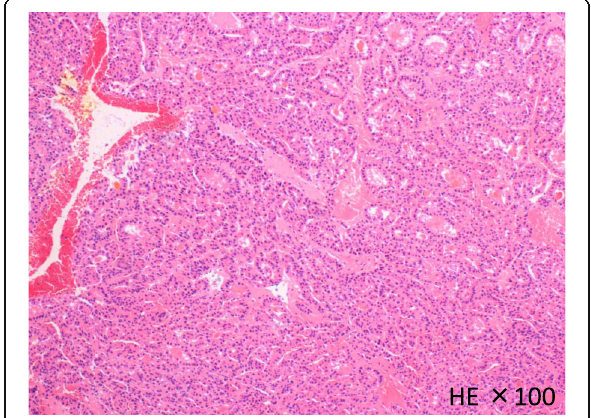
Fig. 4 Pathological findings of resected specimen. Moderately differentiated hepatocellular carcinoma, simple nodular type, 40 × 35 mm, thin-trabecular, and pseudoglandular type: eg, fc(+), fc-inf( − ), Fig. 5 Loupe image of resected specimen. Viable lesions were